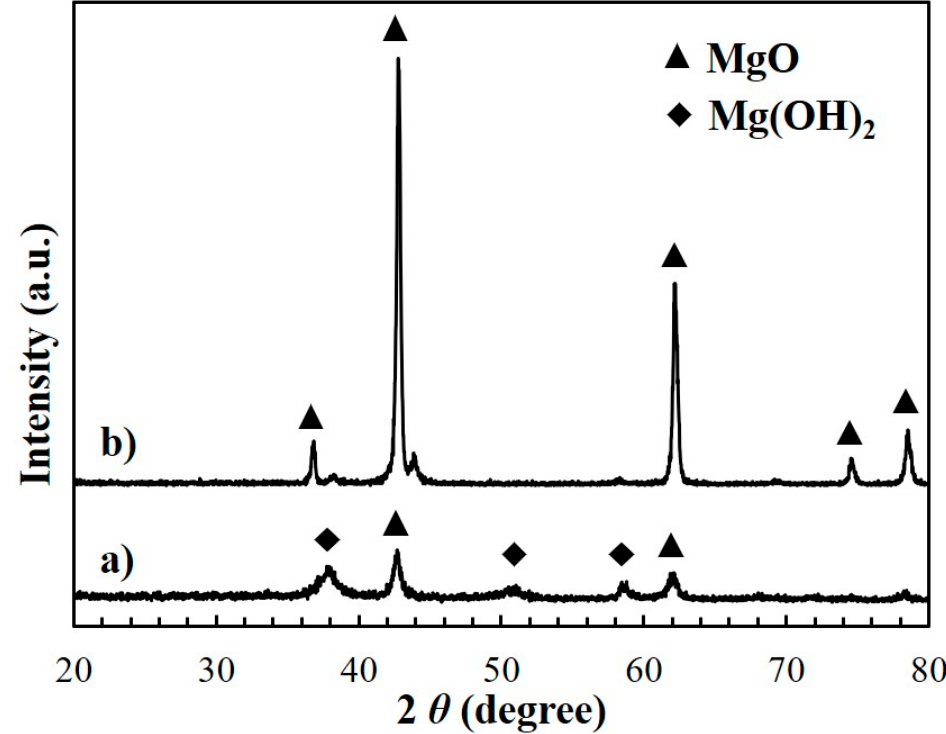
Figure 3. XRD pattern of Cs/Ru/MgO catalyst: ( a ) as-synthesized catalyst and ( b ) used catalyst after reaction of 680 h.